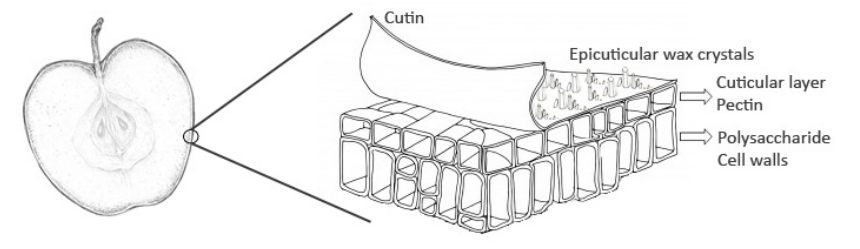
Scheme 1. Schematic organization of the fruit cuticle.